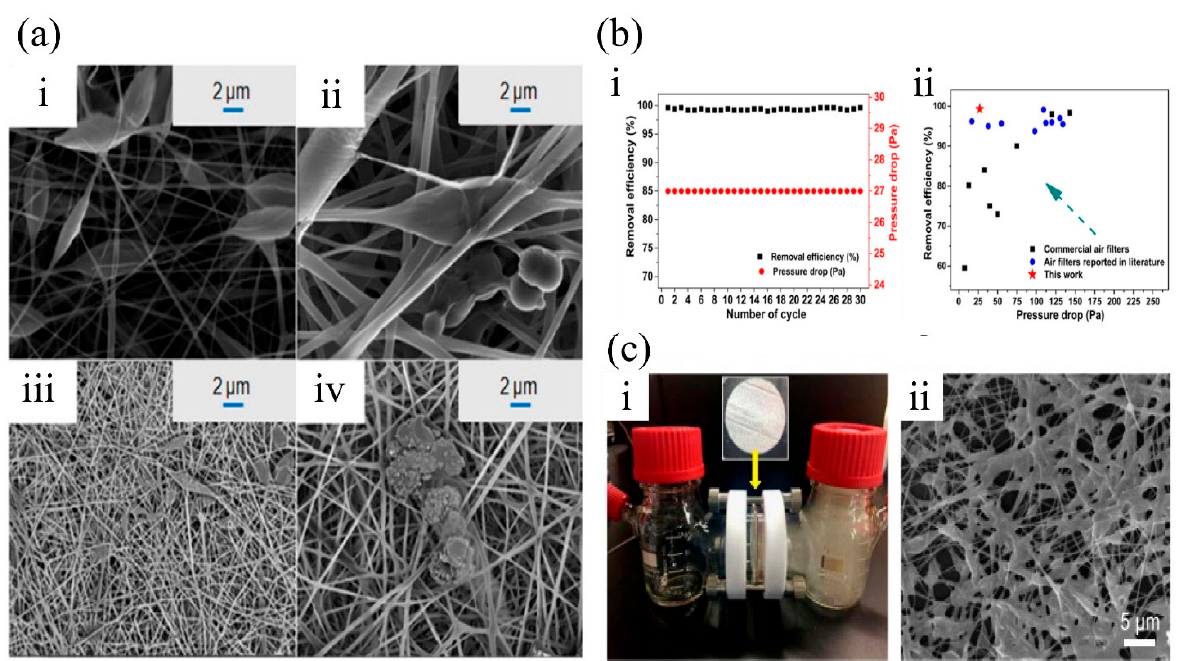
Figure 6. ( a ) Effect of electrospinning distance on the morphology of PLA-PSQ fibrous membranes (( i – iv ) represent the receiving distances of 8, 12, 16, and 20 cm, respectively). Reprinted with permission from ref. [51]. Copyright 2019 The Polymer Society. ( b ) ( i ) Filtration efficiencies of a bead-on-string filter in 30 cycles; ( ii ) comparison figure of the bead-on-string filter with other filters reported in literatures and commercial filter. Reprinted with permission from ref. [52]. Copyright 2019 Elsevier B.V. ( c ) ( i ) Demonstration of GOPAN filter to shut off PM from the outdoor (right bottle). ( ii ) SEM image of GOPAN membrane after filtration test. Reprinted with permission from ref. [53]. Copyright 2018 Elsevier B.V.